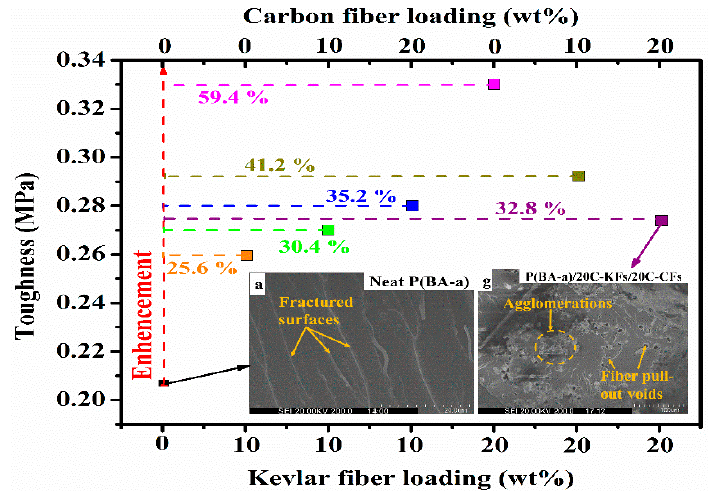
Figure 8. Toughness curve of the P(BA-a)/C–KFs/C–CFs composites.